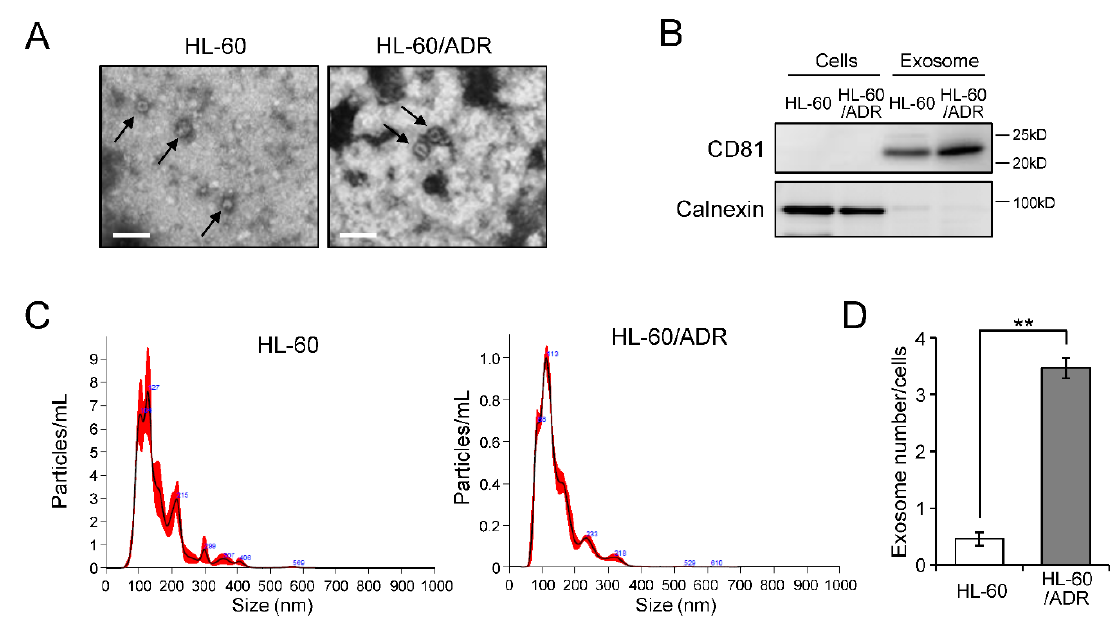
Figure 1. Enhancement of exosome release in HL-60/ADR cells. Exosomes were prepared from the culture media of HL-60 cells and HL-60/ADR cells by sequential ultracentrifugation methods. ( A ) Purified exosomes of HL-60 were observed by transmission electron microscopy. The arrow indicates exosome. Bars, 250 nm. ( B ) Western blot analysis of exosome marker CD81 and endoplasmic reticulum marker calnexin in exosomes and cells. ( C , D ) Exosome size and number were analyzed by nanosight tracking analysis. Particle size distribution of exosomes purified from HL-60 (left) and HL-60/ADR cells (right) are represented ( C ). Exosome numbers were normalized by cell numbers ( D ). Values indicate mean ± SD ( n = 3). ** p < 0.005.